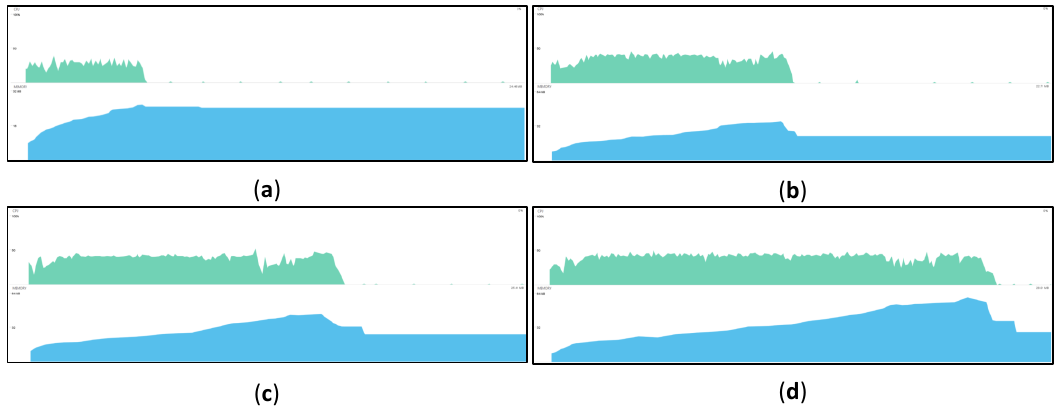
Figure 19. CPU and memory monitoring for registering WSP information. ( a ) Register 1 WSP Information; ( b ) Register 4 WSP Information; ( c ) Register 6 WSP Information; ( d ) Register 9 WSP